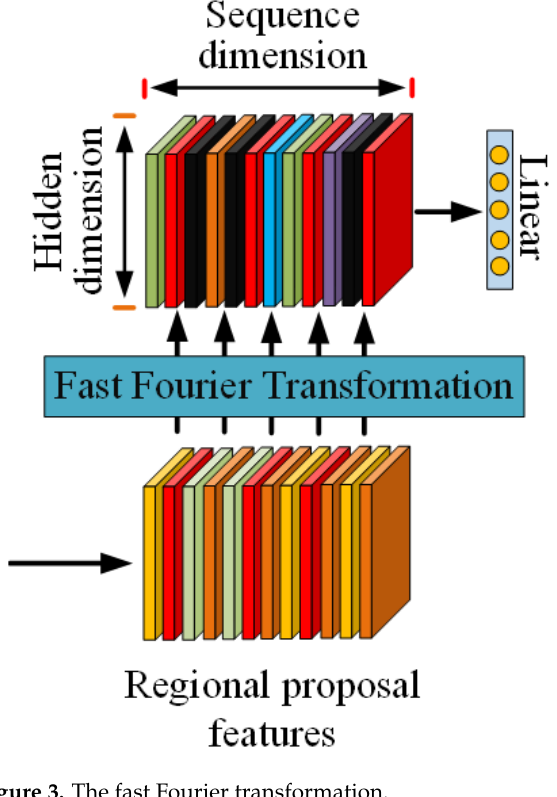
Figure 3. The fast Fourier